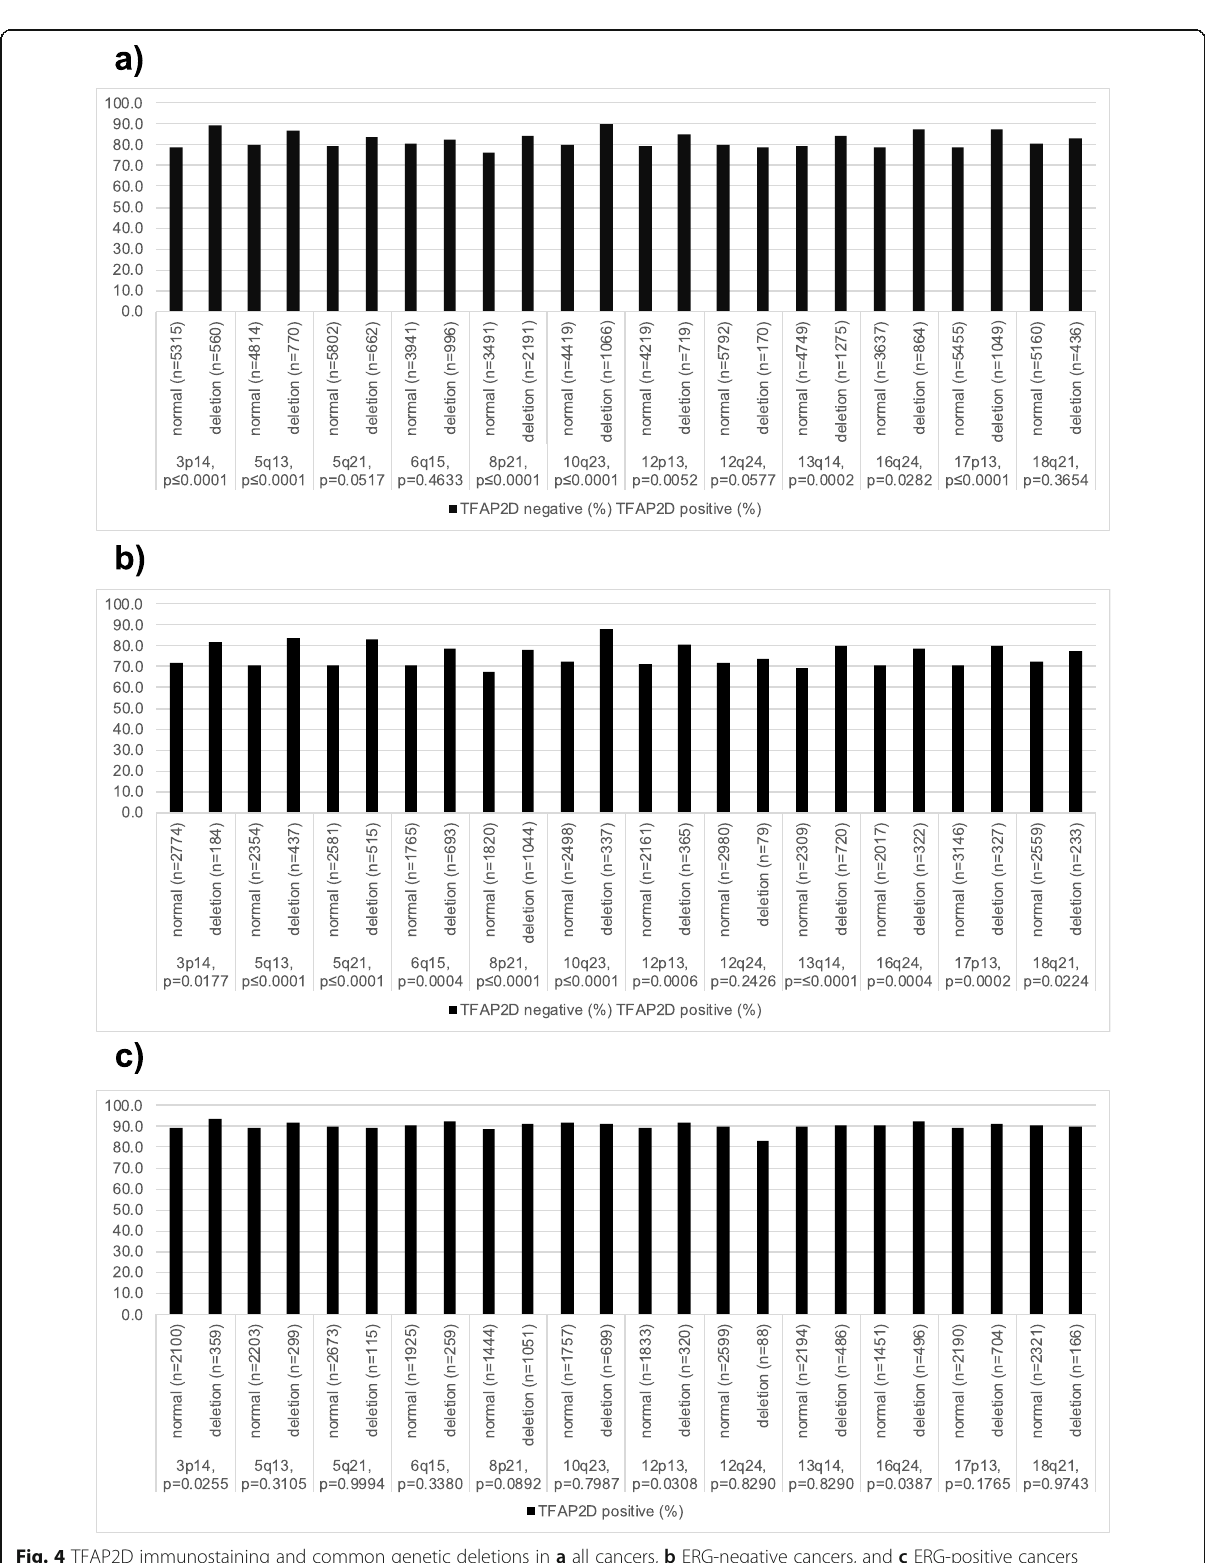
Fig. 4 TFAP2D immunostaining and common genetic deletions in a all cancers, b ERG-negative cancers, and c ERG-positive